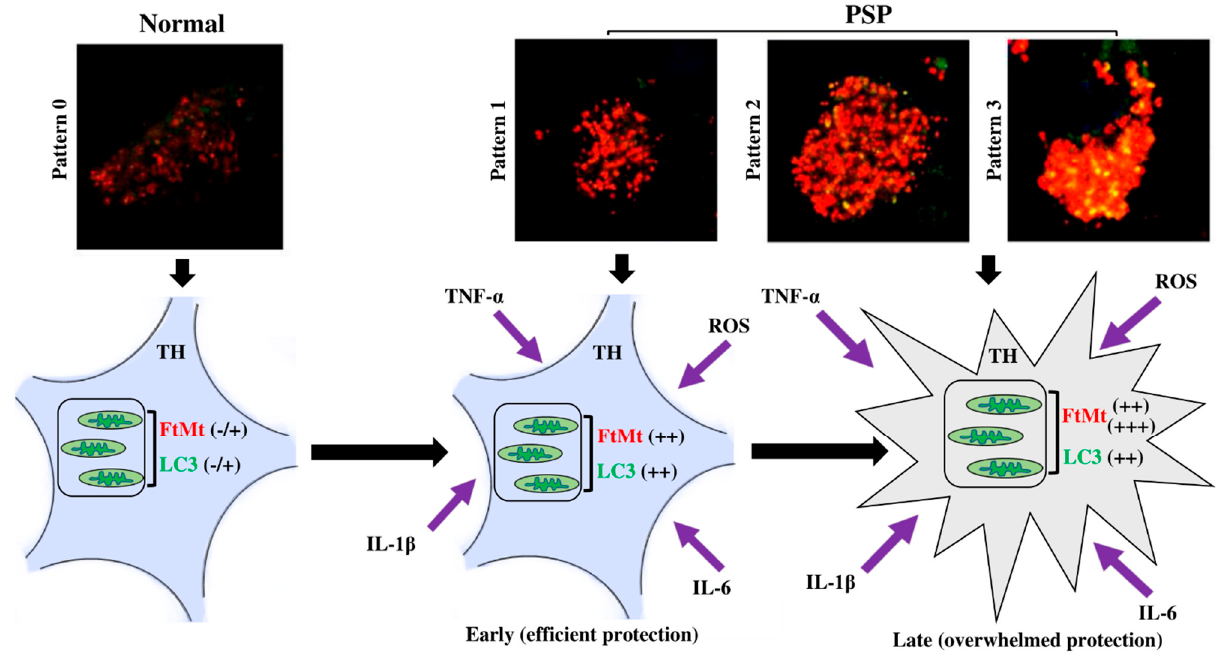
Figure 5. FtMt progression staging and proposed hypothesis for the evolution of function of FtMt, from protective in the early stage of the disease to being overwhelmed in the late stage.